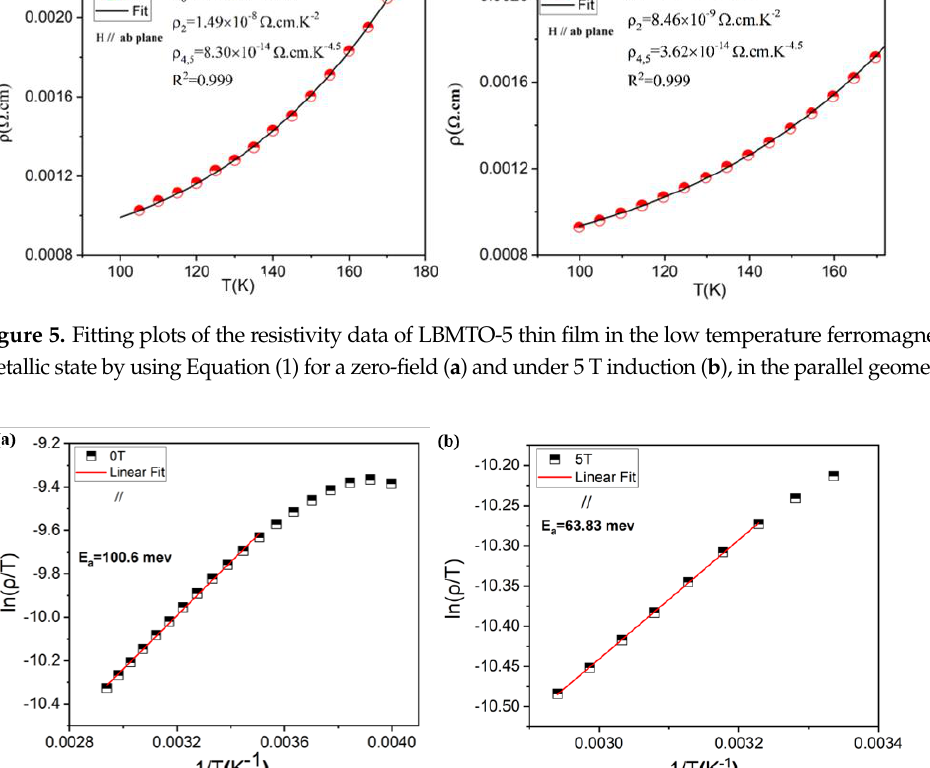
Figure 6. Fitting plots of the resistivity data of ln( ρ /T) as a function of 1/T of LBMTO-5 thin film in the paramagnetic semiconductor region by using Equation (2) for a zero-field ( a ) and under 5 T ( b ), in the parallel geometry.